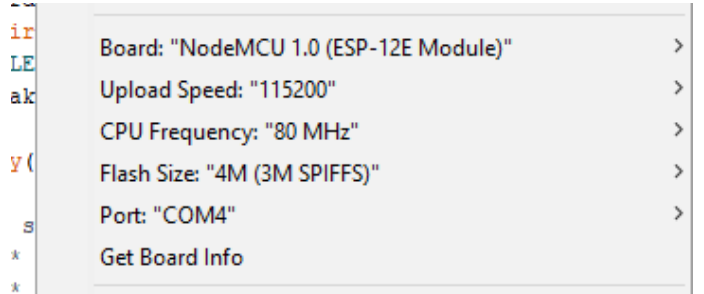
Figure 4. Arduino parameter settings used.